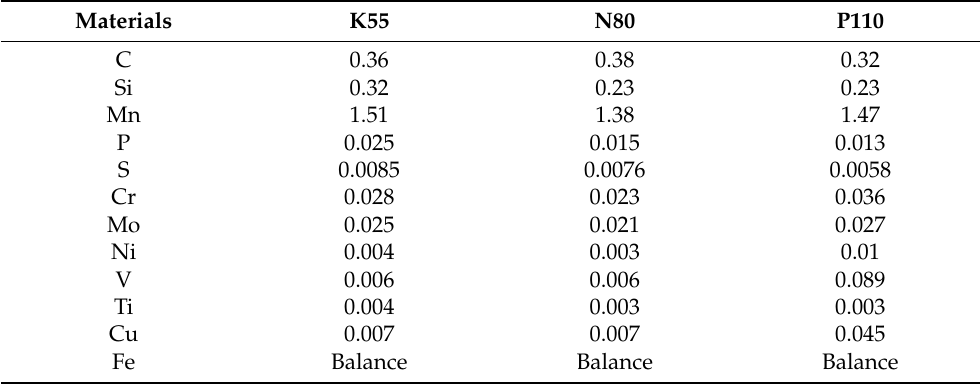
Table 1. Chemical compositions of different casing drilling steels